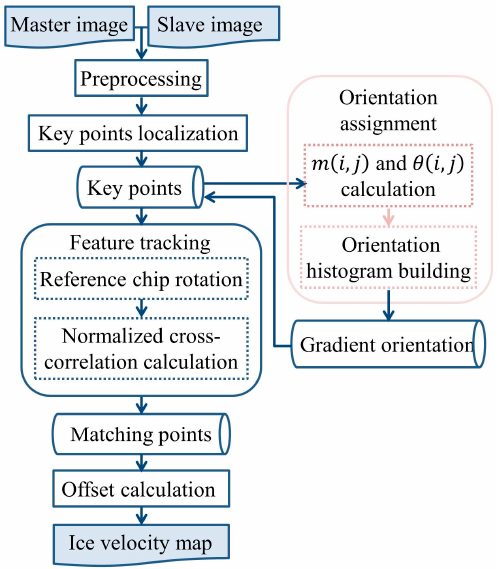
Figure 4. The flowchart of the rotation-invariant feature-tracking method.